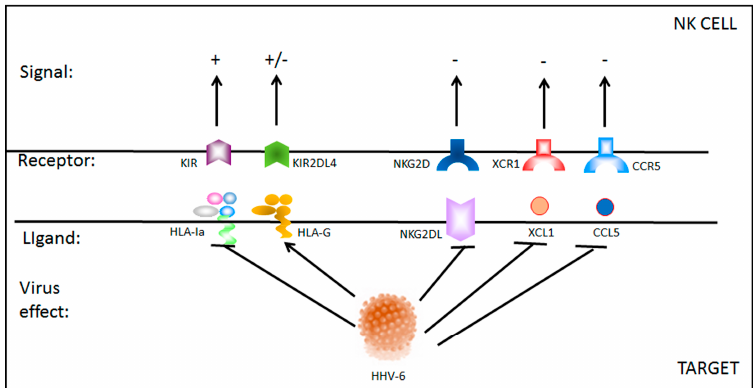
Figure 2. HHV-6 effect on NK cell receptor–ligand interaction. During HHV-6 infection, both NK cells and infected target cells present a modified pattern of receptor–ligand expression, that affect NK cell status. KIR: killer immunoglobulin-like receptors with inhibitory functions; KIR2DL4 with both inhibitory and activating functions; NKG2D activating receptor; XCR1 and CCR5 (C-C chemokine receptor) chemokine receptors. Virus effect: arrow means activated, T bar means inhibited; signal: + means activating signal, +/ − means both activating and inhibitory signal, − means inhibitory signal.